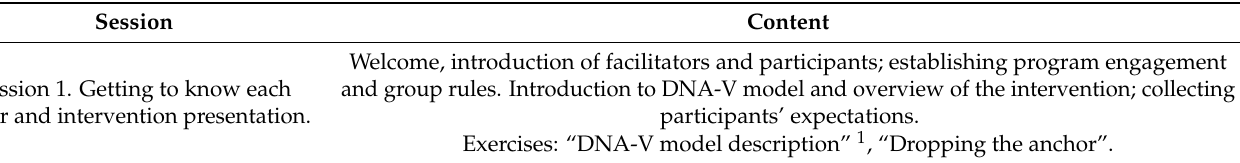
Table A1. Session-by-Session Outline of the ME-WE Intervention